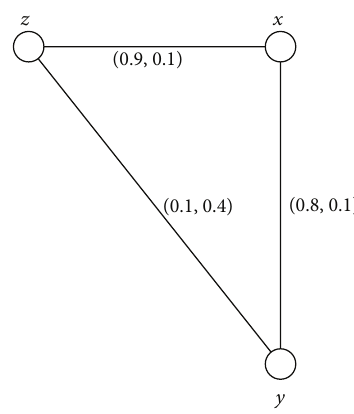
Figure 2: Connected intuitionistic fuzzy